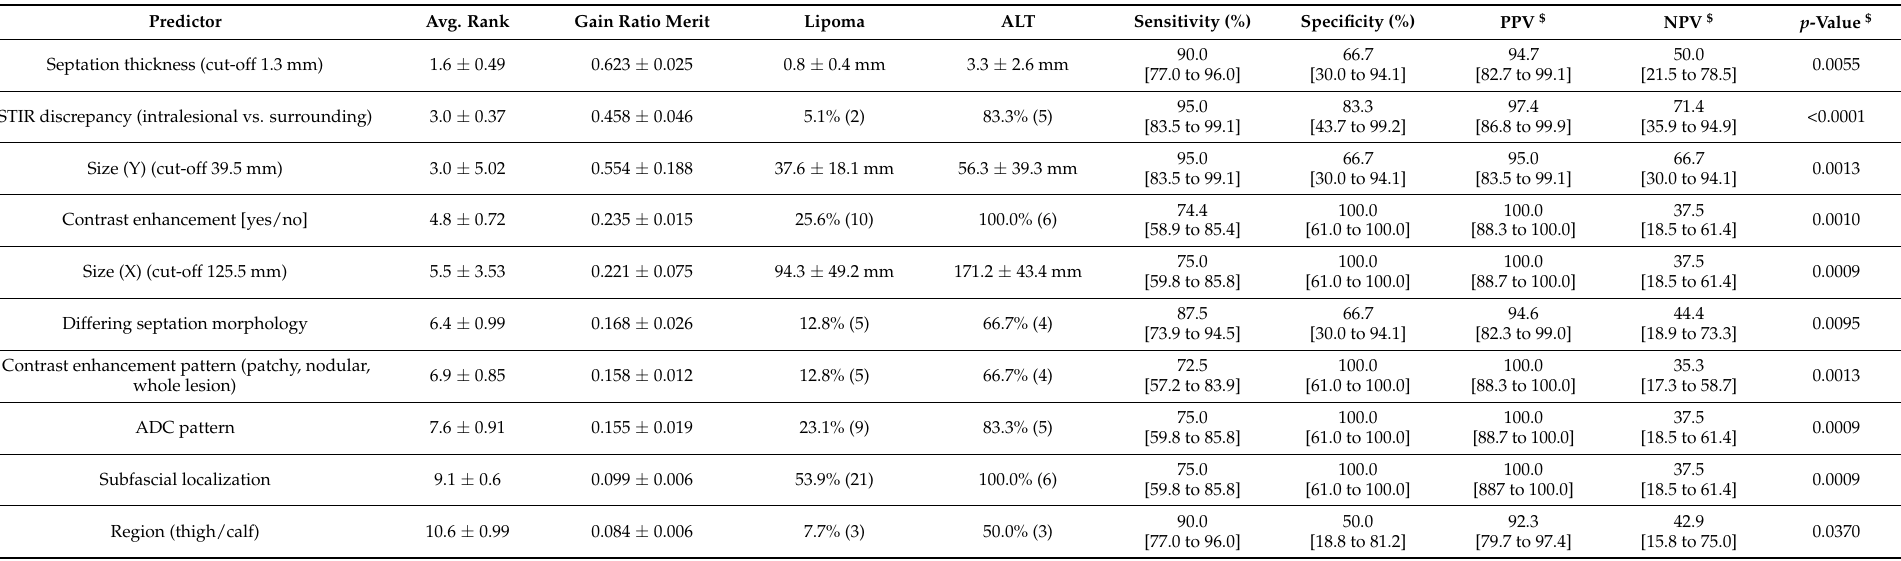
Table 3. Gain-ratio merit predictor ranking for ALT differentiation in lipomatous tumors (absolute values in parentheses).